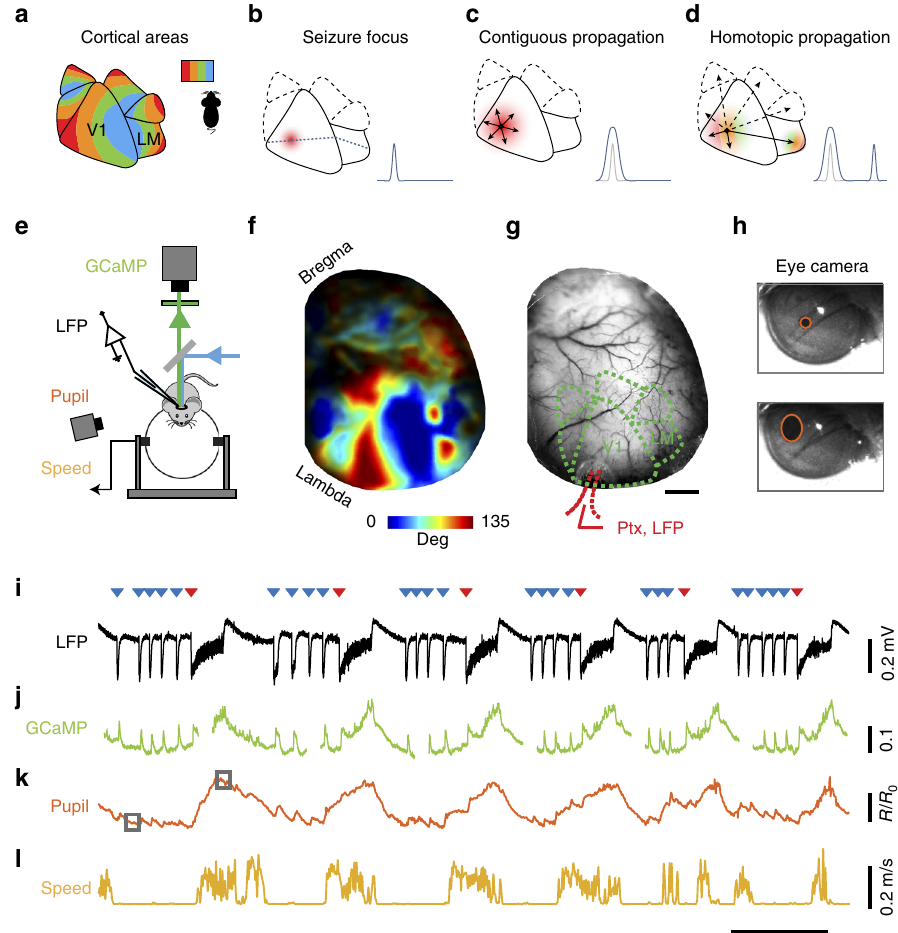
Fig. 1 Testing hypotheses for cortical seizure propagation with simultaneous imaging, recordings and behavioral measurements in the awake mouse. a Cartoon of mouse visual cortex showing six visual areas in the right hemisphere, each containing a map of the left visual fi eld. Colors indicate territories that prefer the same horizontal position. V1 and LM are the primary and secondary visual areas. b Cartoon depicting elevated activity in the seizure focus in V1. Dotted line through the epileptic focus connects V1 and LM regions that prefer the same vertical position. Inset : Pro fi le of activity along that line. c Contiguous propagation hypothesis: local mechanisms make seizure spread radially to nearby territories. Inset : pro fi le of idealized activity at onset ( gray ) and during spread ( blue ). d Homotopic propagation hypothesis: long-range connections generate secondary distal foci in homotopic locations in higher visual areas. Inset as in c . e Schematic of the experimental set-up. f Example retinotopic map obtained from a GCaMP6f mouse. Colors indicate preferred horizontal position ( color bar ). g Image acquired during simultaneous wide fi eld imaging and LFP recordings. Red dots highlight location in V1 of pipette for injection of Picrotoxin (Ptx) and recordings of local fi eld potential (LFP). Scale bar indicates 1mm. h Frames from the eye camera taken when the pupil was constricted ( top ) or dilated ( bottom ), with fi tted ellipses ( red ). i LFP traces measured during epileptiform activity, showing seizures ( red triangles ) and interictal events ( blue triangles ). j Simultaneous GCaMP fl uorescence, averaged over the imaging window (discontinuities indicate pauses in image acquisition). k , l Behavioral measures during epileptiform discharges: pupil dilations ( k ) and running speed ( l ). Squares in k indicate times of example frames in